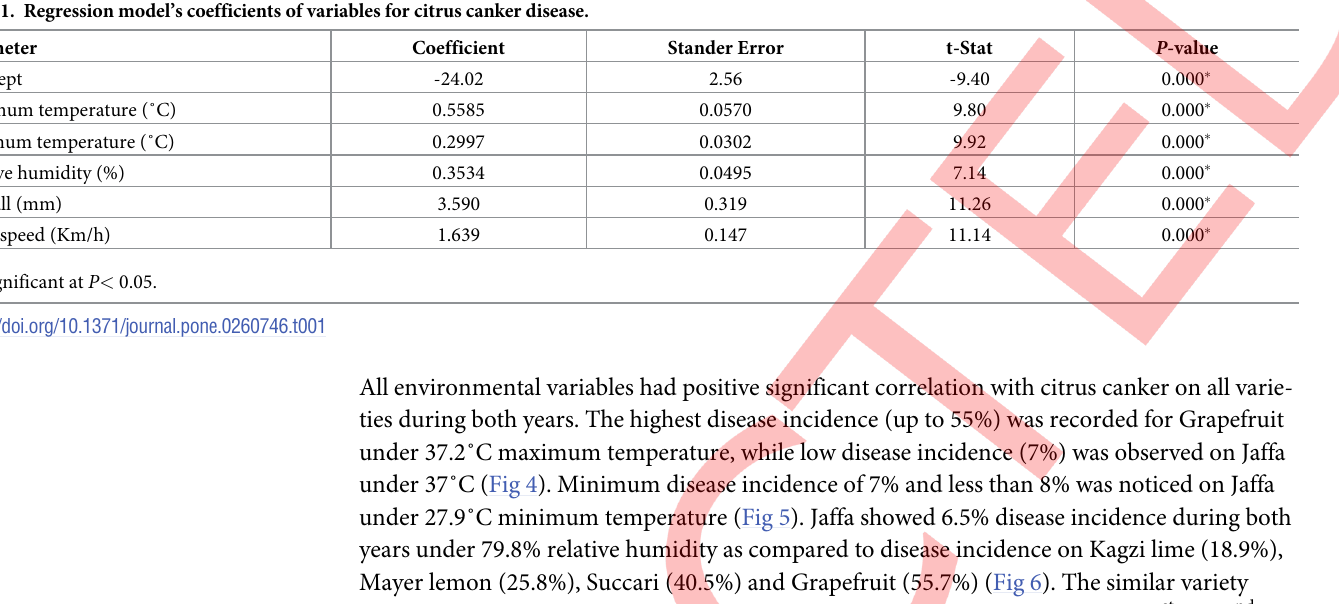
Table 1. Regression model’s coefficients of variables for citrus canker disease.